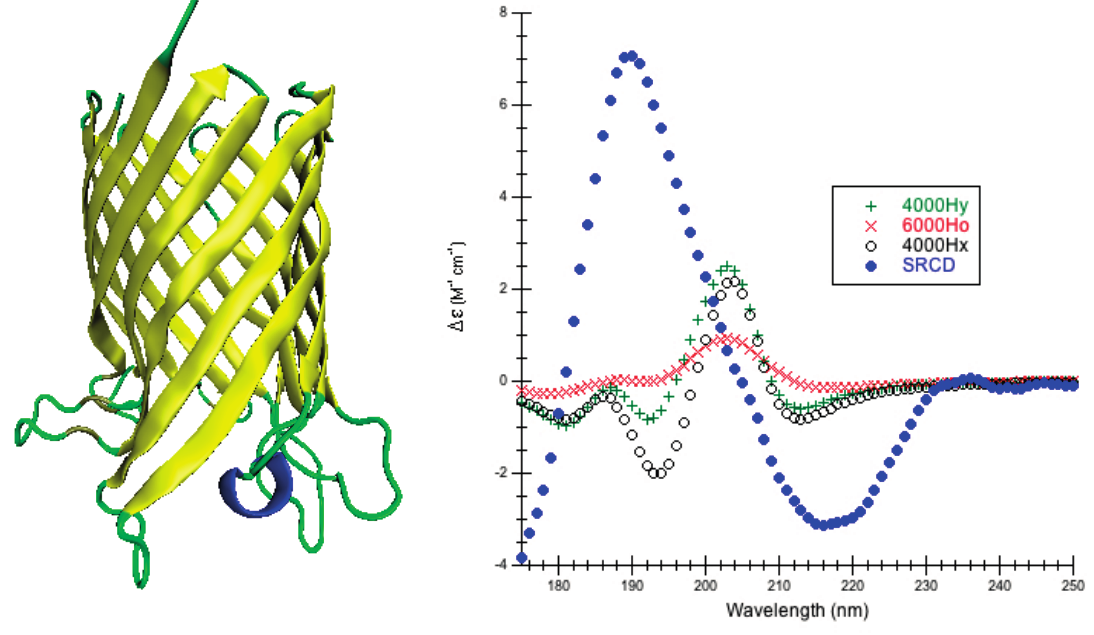
Figure 4. Outer Membrane Protein G. ( Left ) Secondary structure of outer membrane protein G (PDB code 2IWV [62]): the blue cartoons/coils correspond to α -helices (140–145), the yellow tapes are β -sheets (7–19, 43–56, 61–62, 70–79, 83–97, 204–218, 229–243, 248–261, 267–289), and the thin green ropes are turns and other structures; ( Right ) Predicted CD using CDCALC. The 2IWV structure was minimized via NAMD/CHARMM22/10,000 conjugate gradient steps. All CH 3 group hydrogens are ignored. The 6000 and 4000 refer to bandwidths in cm − 1 . Calculated spectrum show the smallest RMSD 6000Ho (×), the largest RMSD 4000Hx (o), and an example helical parameter result, 4000Hy (+). The blue dots (•) are the experimental SRCD (CD0000119000) [44,59]. The CATH fold classification [53] is mainly beta/beta